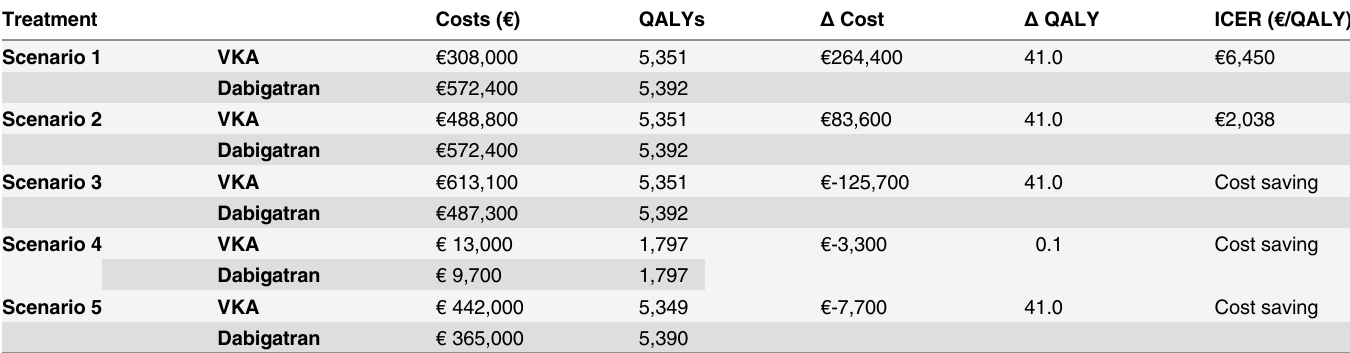
Table 4. Incremental costs, QALYs and ICER in various scenarios.